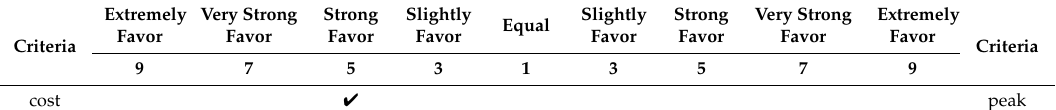
Table 2. Second evaluators’ comparison according to Saaty’s scale.